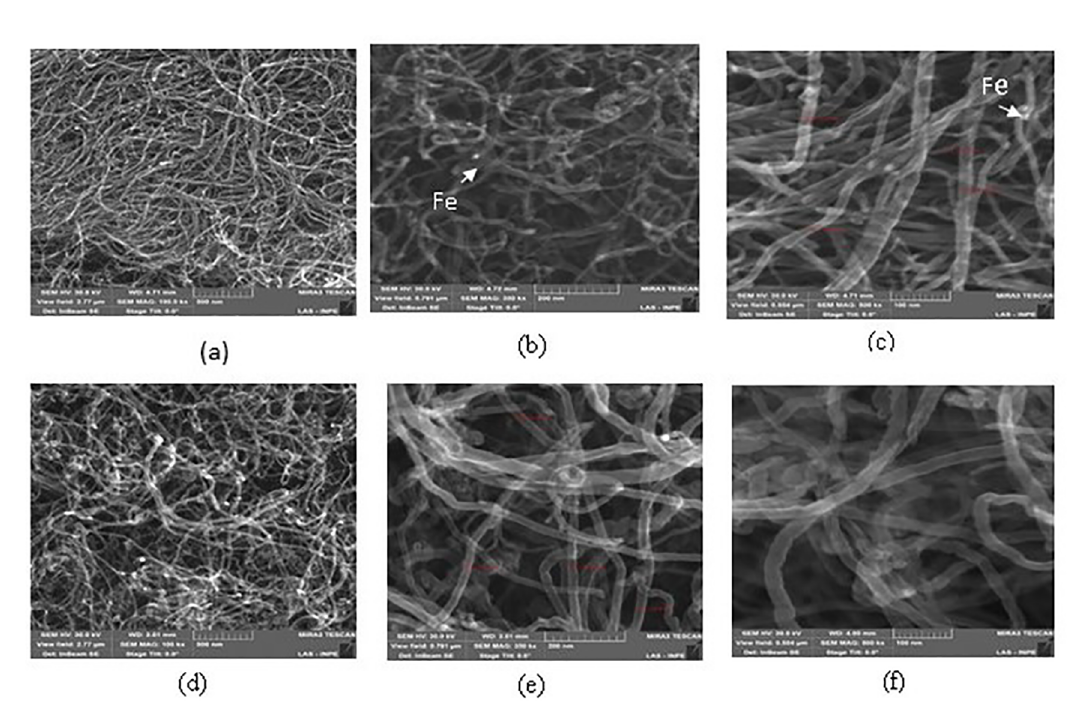
Figure 3. SEM-FEG of CNT-B: (a) 100000x, (b) 350000x, (c) 500000x, and CNT-K: (d) 100000x, (e) 350000x, (f) 500000x The full width at half maximum (FWHM) of the peak (002) may be used to evaluate the degree of ordering of CNT samples. In this context, the smallest value of FWHM of the CNT-B (0.044 rad) shows more clearly that this sample presents a better structural ordering than CNT-K (0.052 rad), i.e. narrower peaks refer to more well-ordered crystalline